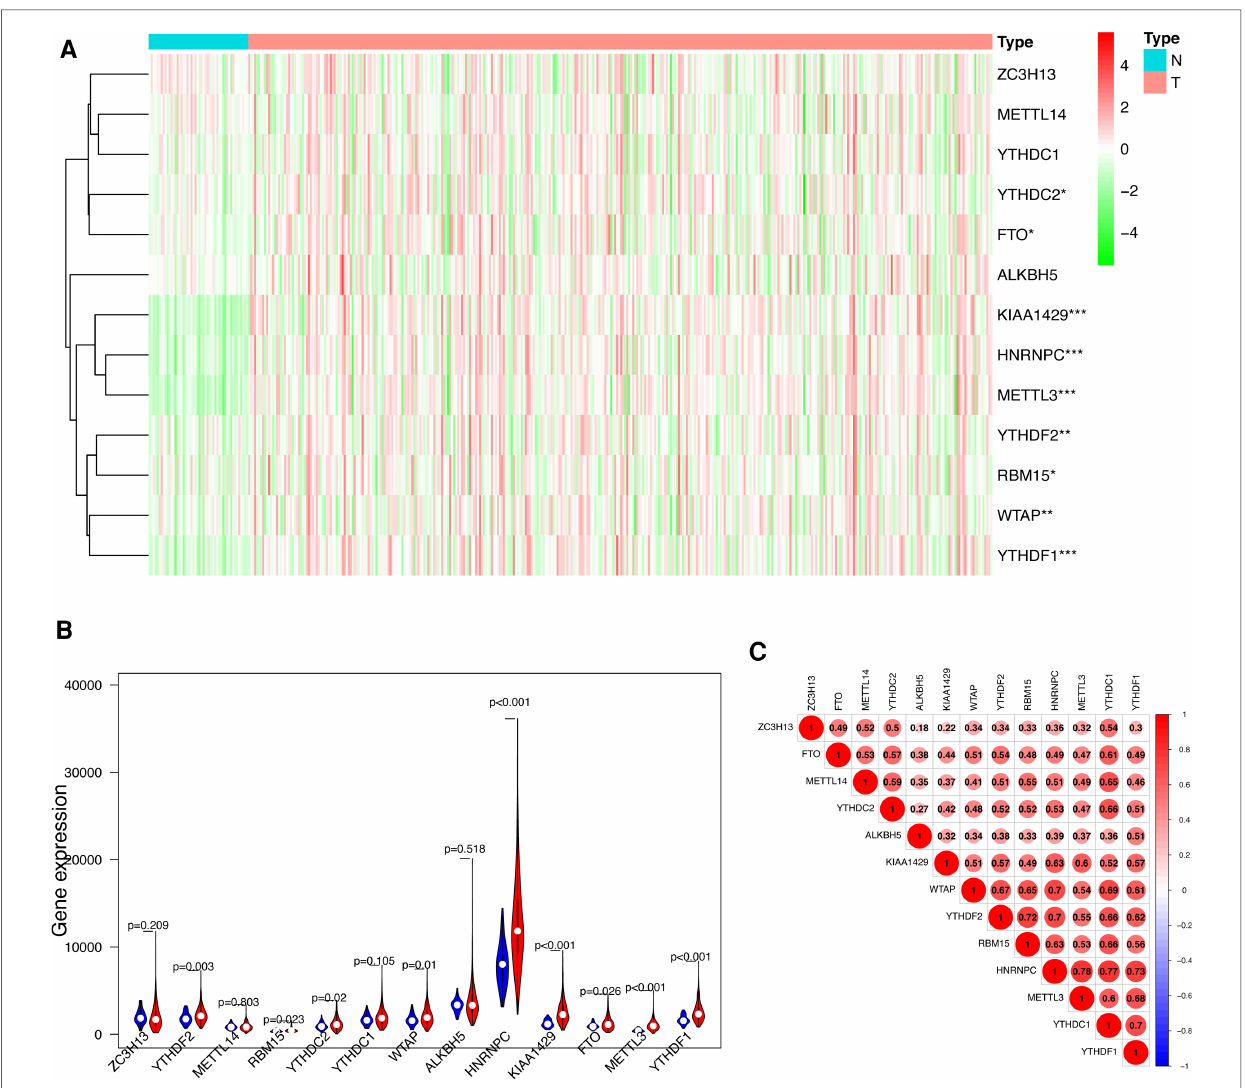
FIGURE 1 Differentially expressed m6A methylation-related genes between HCC and normal tissues. ( A ) Heatmap of differentially expressed m6A methylation- related genes. ( B ) The expression patterns of differentially expressed m6A methylation-related genes in HCC and normal tissues. Red, tumor tissues; Blue, normal tissues. ( C ) The correlation among m6A methylation-related